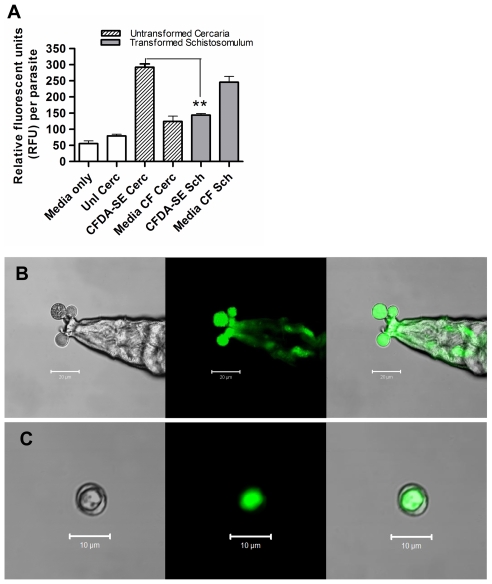
Transformation of cercariae into schistosomula results in the release of CFDA-SE labelled ES gland material.A; The RFU of CFDA-SE labelled untransformed cercariae and transformed schistosomula was compared after 3 hrs of culture (Unl cerc = unlabelled cercariae, CFDA-SE cerc = CFDA-SE labelled cercariae, Medium CF cerc = Medium from untransformed CFDA-SE labelled cercariae, CFDA-SE Sch = CFDA-SE labelled schistosomula, Medium CF Sch = medium from labelled transformed schistosomula). Results are mean±SEM from 5 independent experiments; significant difference of transformed schistosomula versus untransformed cercariae P<0.01. B; Representative confocal images of a transforming CFDA-SE-labelled cercaria showing the release of gland material (C) as discrete vesicles.